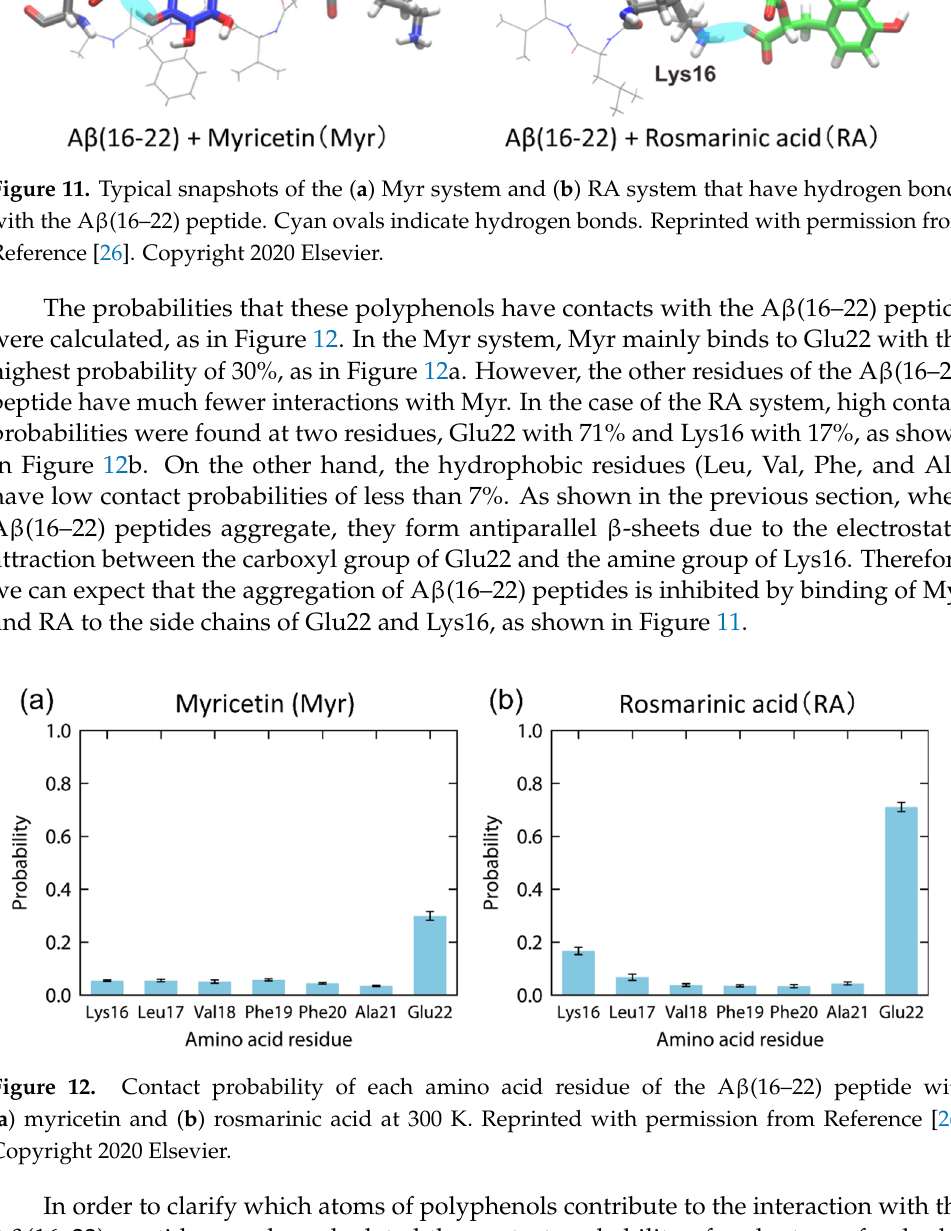
Figure 13. Color mapping of contact probability of the ( a ) myricetin and ( b ) rosmarinic acid atoms with the A β (16–22) peptide at 300 K. Reprinted with permission from Reference [26]. Copyright 2020 Elsevier. 5. Conclusions We presented molecular dynamics (MD) simulations of an A β 40 peptide and A β (16– 22) fragments to study the aggregation process and the binding structures of drug candi-